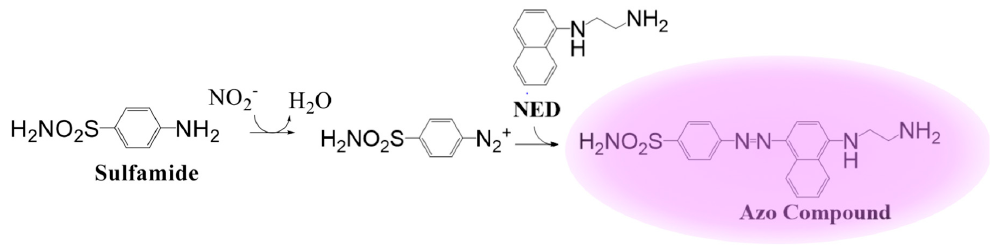
Figure 2. The Griess assay that is currently commercially available from Promega has undergone many changes and optimizations, but the diazotization reaction published by Griess is still the central component of the Griess test [58,59].